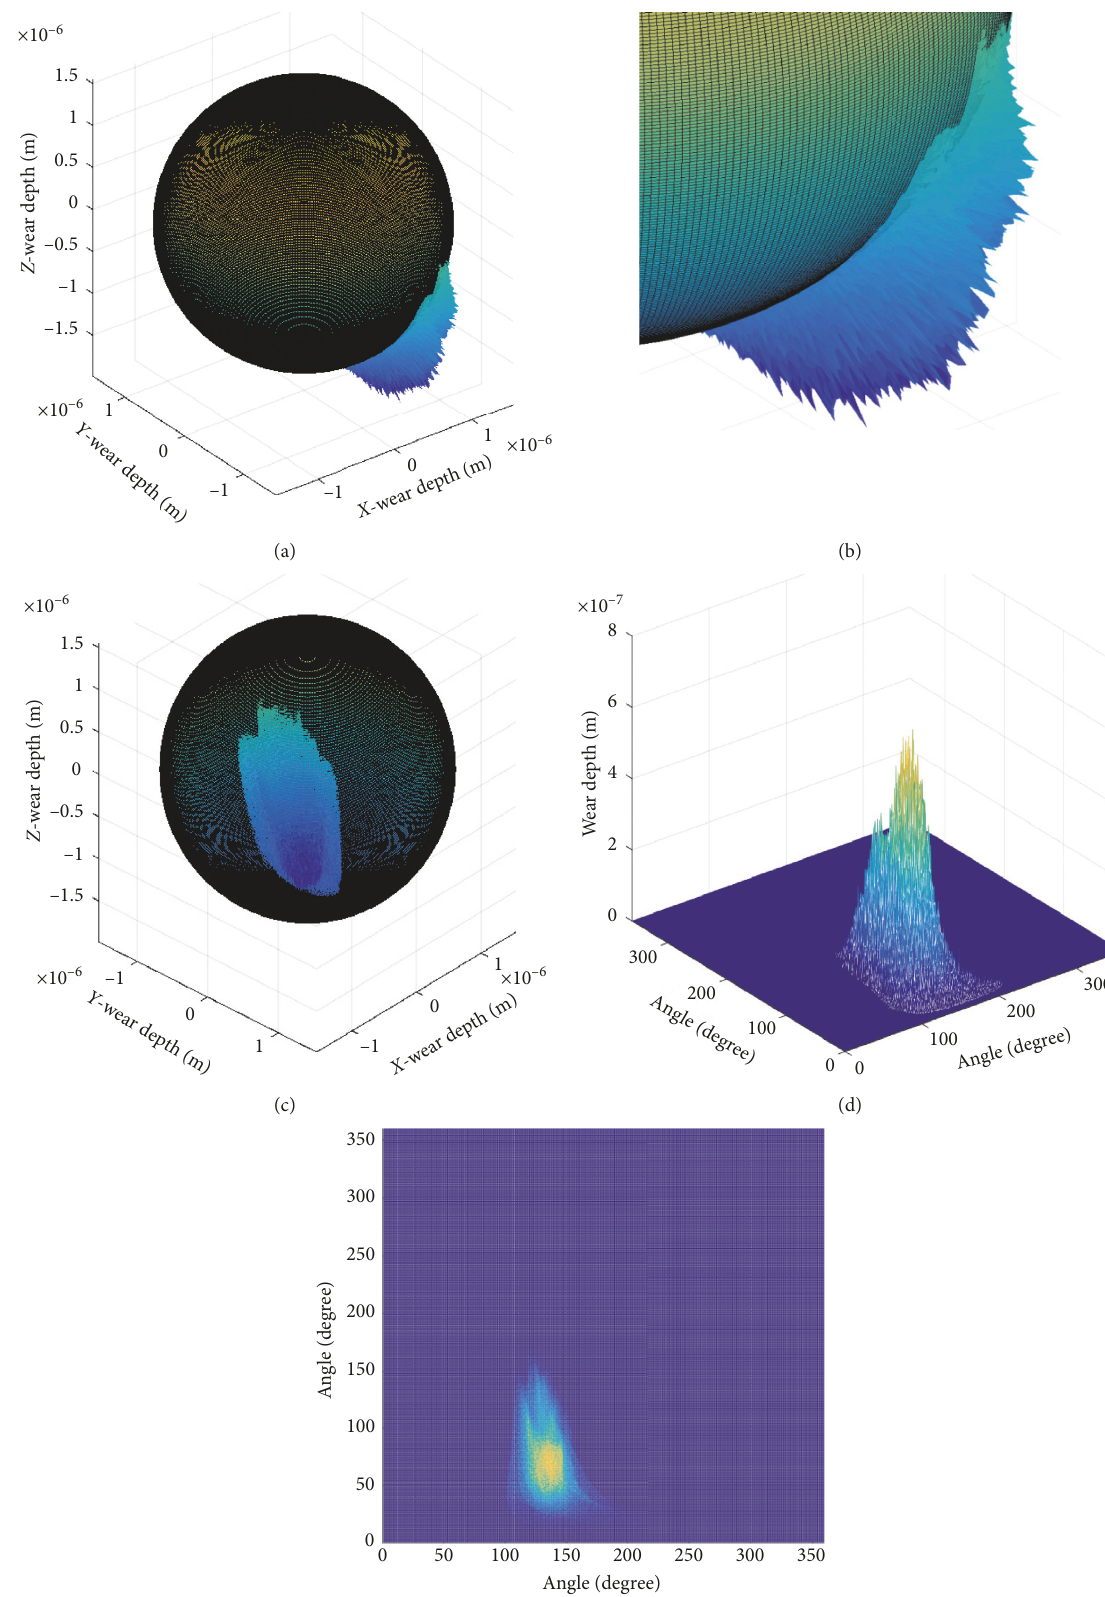
Figure 9: Wear condition of the spherical joint with clearance: (a) Geometric reconstruction surface, (b) enlarged view of the geometric reconstruction surface, (c) wear region, (d) wear depth, and (e) two-dimensional expansion diagram of wear